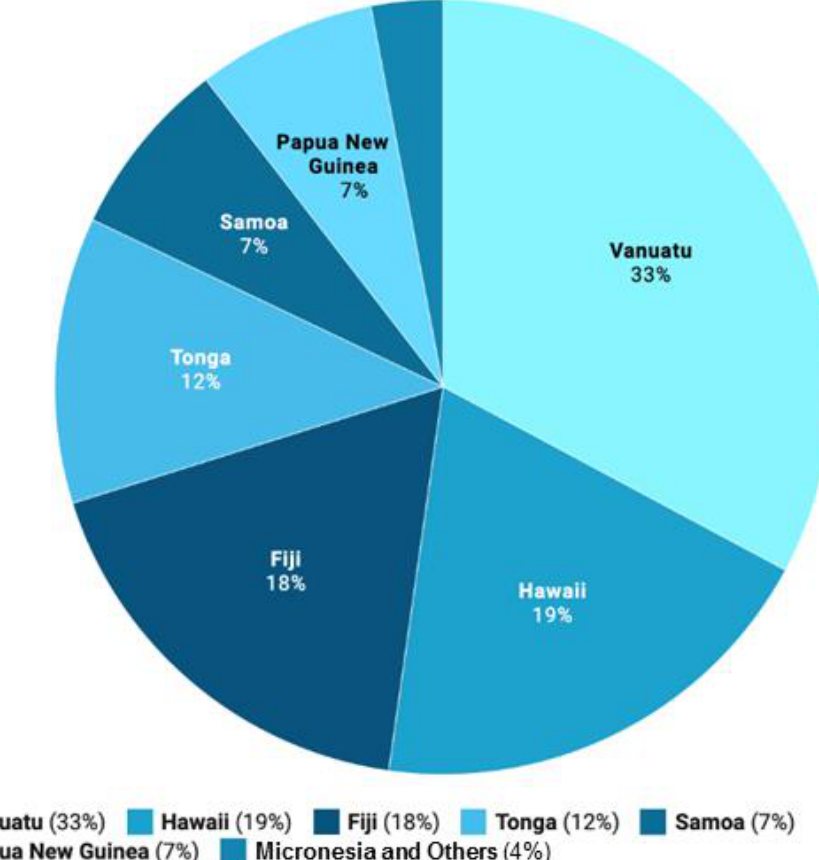
Figure 5. Distribution of kava cultivars among primary producers.